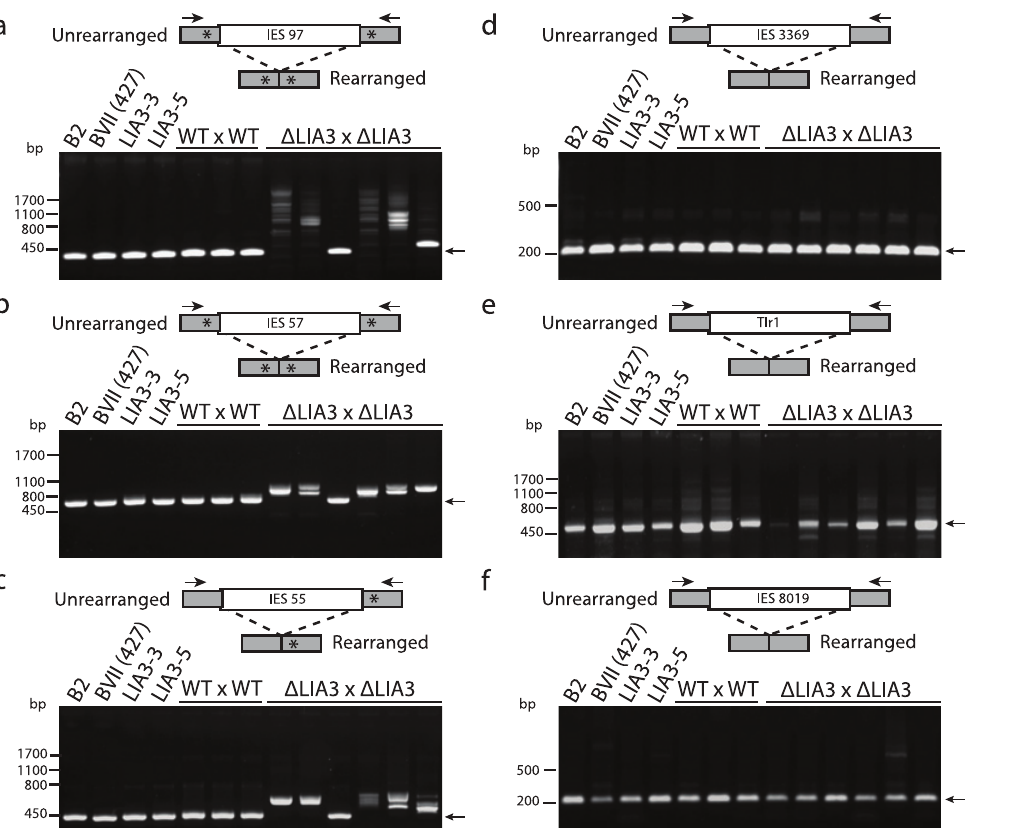
Fig 4. Δ LIA3 lines aberrantly rearrange IES flanked by A 5 G 5 . Lanes 1 – 4 are from the wt and Δ LIA3 parent lines used for the matings in lanes 5 – 13. (a-c) PCR across rearrangement junction of IES flanked by A 5 G 5 that display aberrant rearrangement in Δ LIA3 matings. (d-f) PCR across rearrangement junction of IES not flanked by A 5 G 5 that rearrange normally in Δ LIA3 matings. Black arrows, pcr primers; asterisks, polypurine tracts; grey boxes, flanking sequences; white boxes, IES. IES 55 has a sequence resembling a polypurine tract only on its right